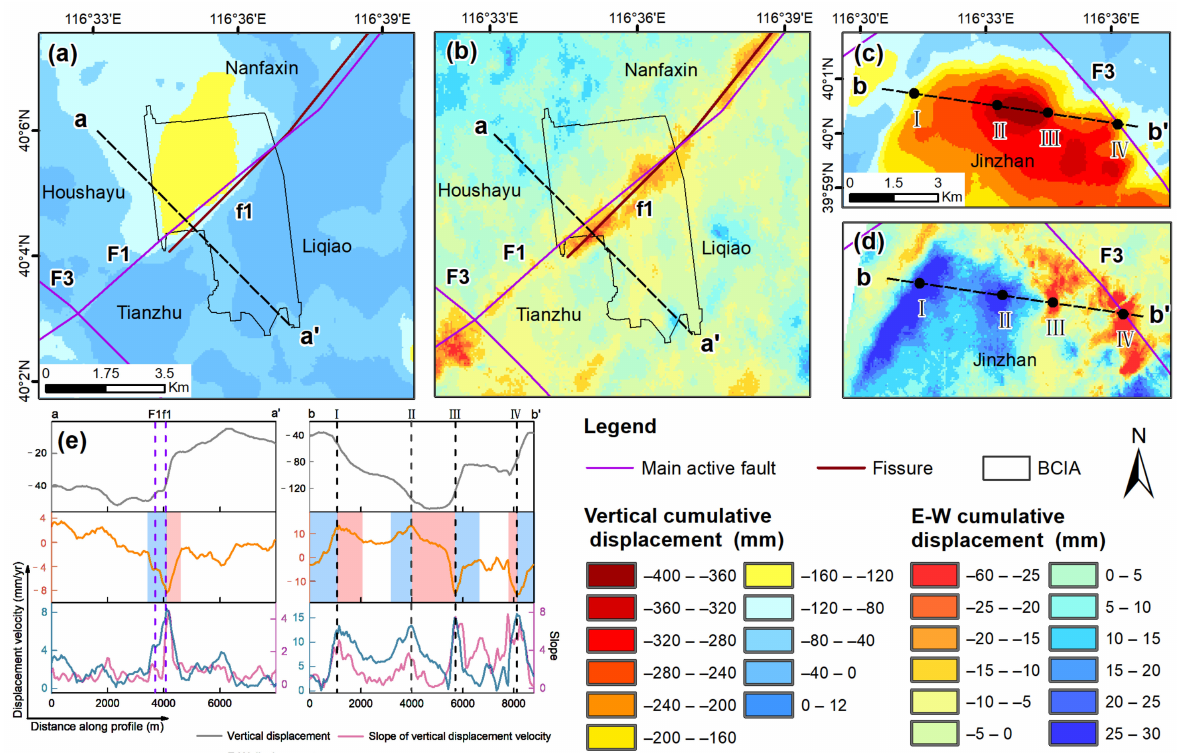
Figure 11. Magnified views of the highlighted areas. ( a , b ) Beijing Capital International Airport (BCIA); ( c , d ) Jinzhan. ( e ) shows vertical and east–west horizontal displacement rates (2016–2018) and displacement rate gradients along the two profiles whose positions are marked in Figure 7. I, II, III, and IV are representative points on profile b-b (cid:48) . The violet dashed lines indicate the locations of ground fissures and faults. F1: Shunyi–Liangxiang fault. F3:Nankou–Sunhe fault. a–a (cid:48) , b–b (cid:48) are the displacement profiles within depressions are marked by black dashed lines The unit of the slope is 10 − 3 ◦